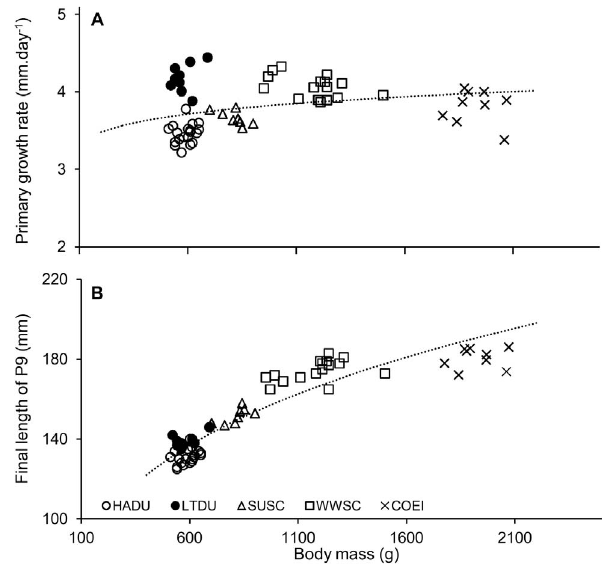
Figure 2. Relationships between body mass and primary growth rate, and P9 length in 5 seaduck species. Allometric relationships among 5 seaduck species between: ( A ) body mass (g) and delta 9 th primary growth rate (mm.day 2 1 ), ( B ) body mass (g) and final length of 9 th primary (mm). Dotted line represents the allometric relation for the 5 species (HADU, LTDU, SUSC, WWSC and COEI) ( A ) allometric relation: M 0.059 , ( B ) allometric relation: M 0.285 .